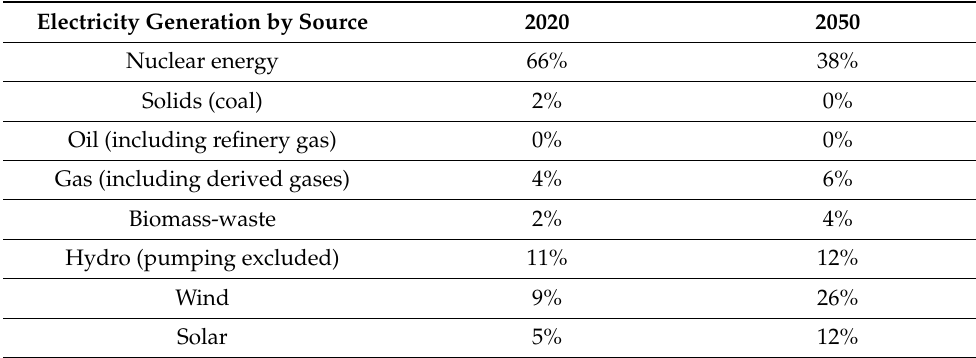
Table 1. Share of the electricity mix composition by sources used to perform the study. Electricity Generation by